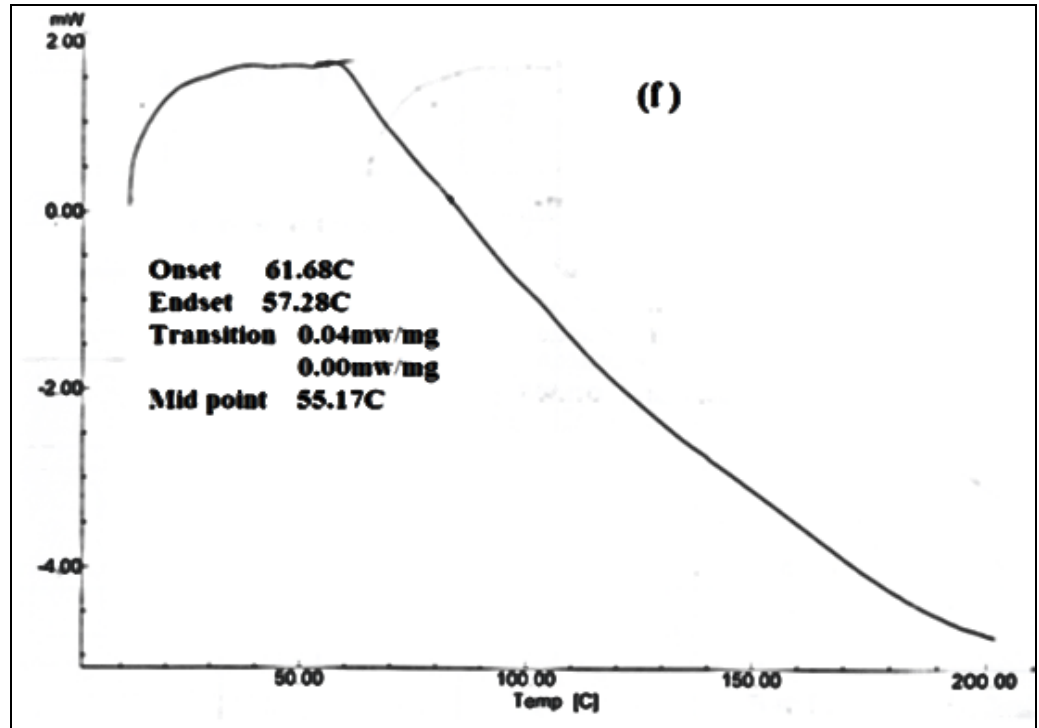
Fig.22: (Temperature glass transition) curves for UP/ nano SiO